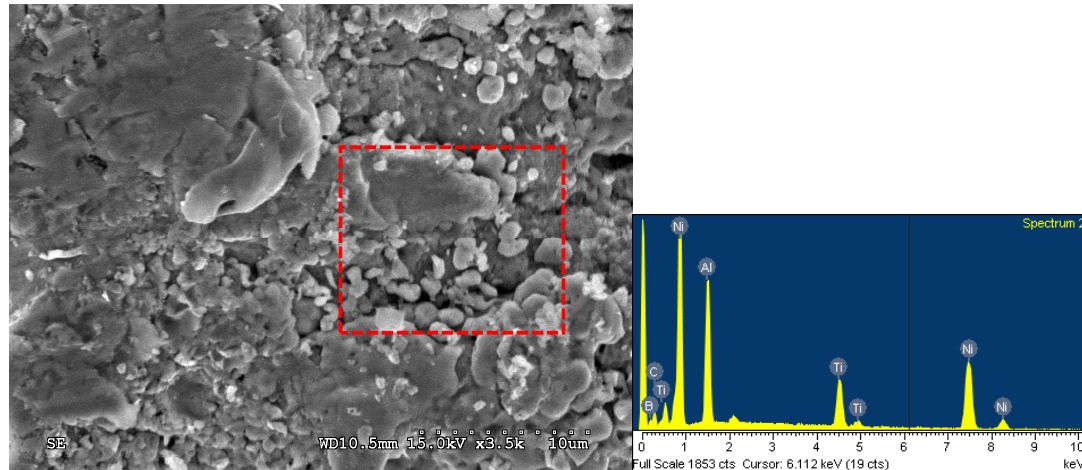
Figure 7. SEM micrograph and EDS spectrum of the 5Ni 3 Al + 2TiB 2 + TiC composite synthesized from Reaction (2).